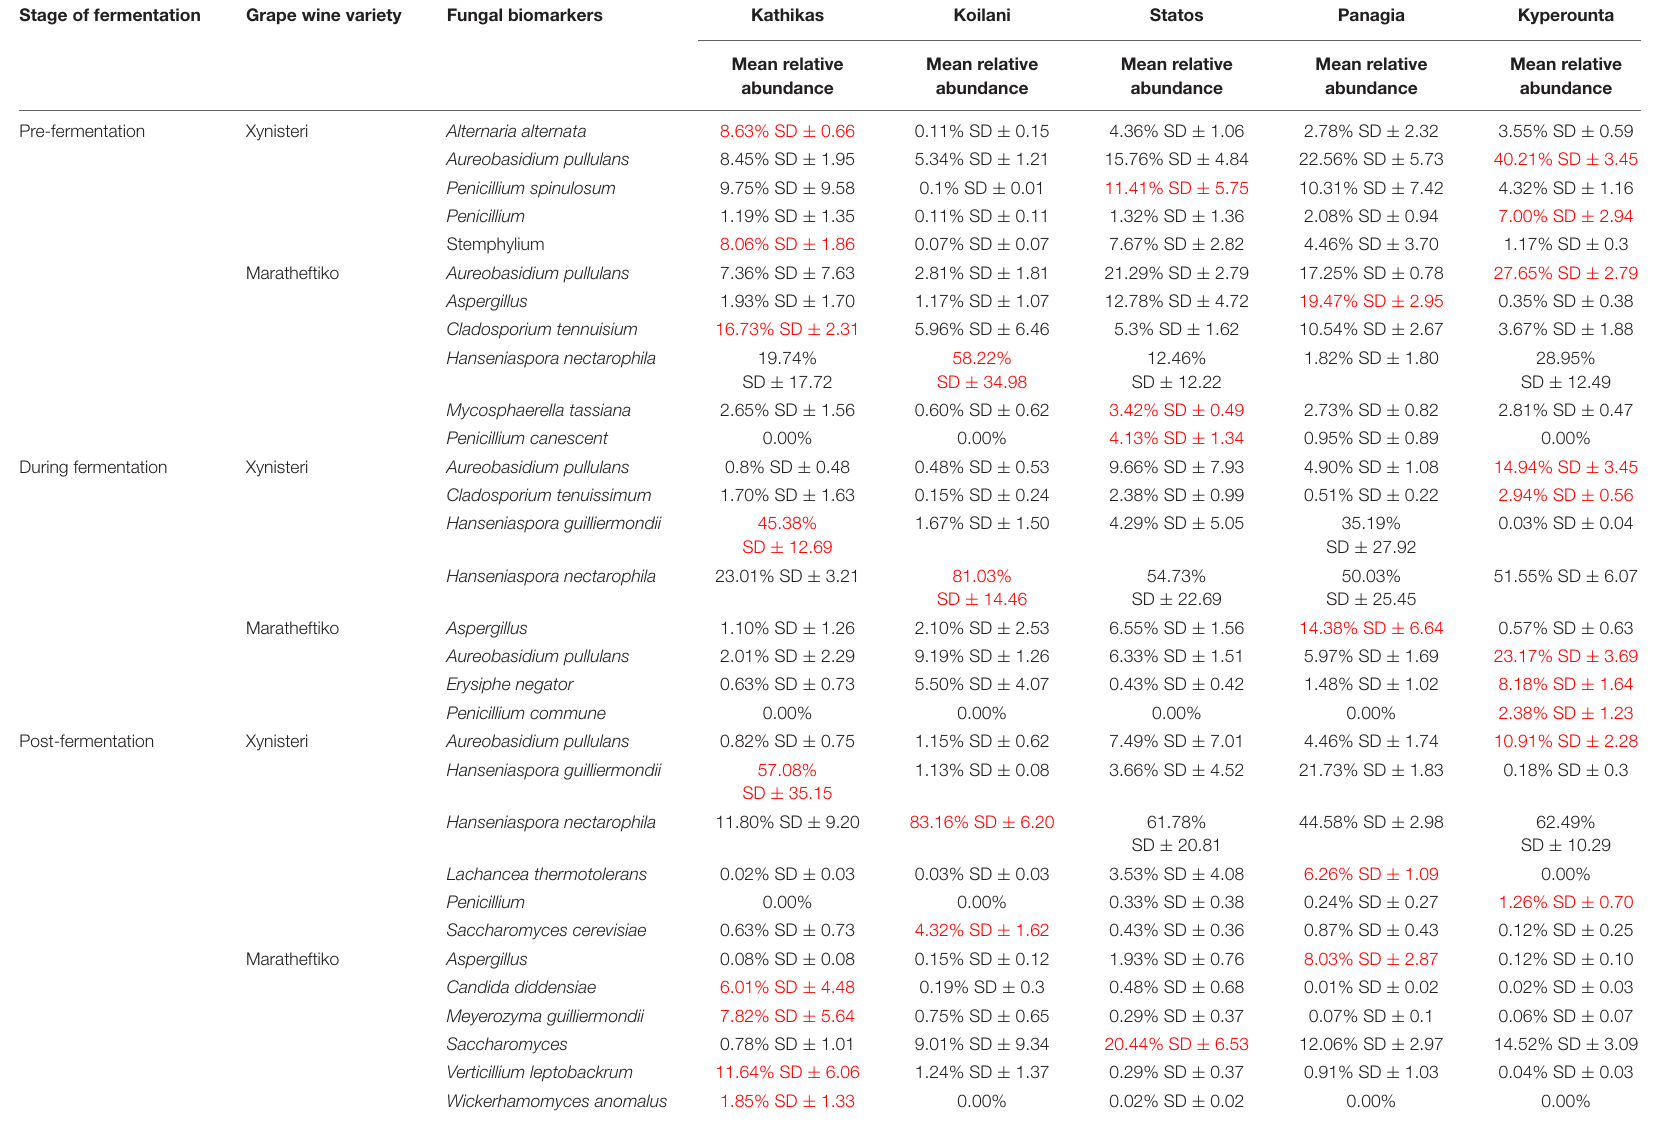
TABLE 1 | Fungal taxa with significantly higher relative representation in a specific terroir (highlighted with red) for the two grape wine varieties during the process of